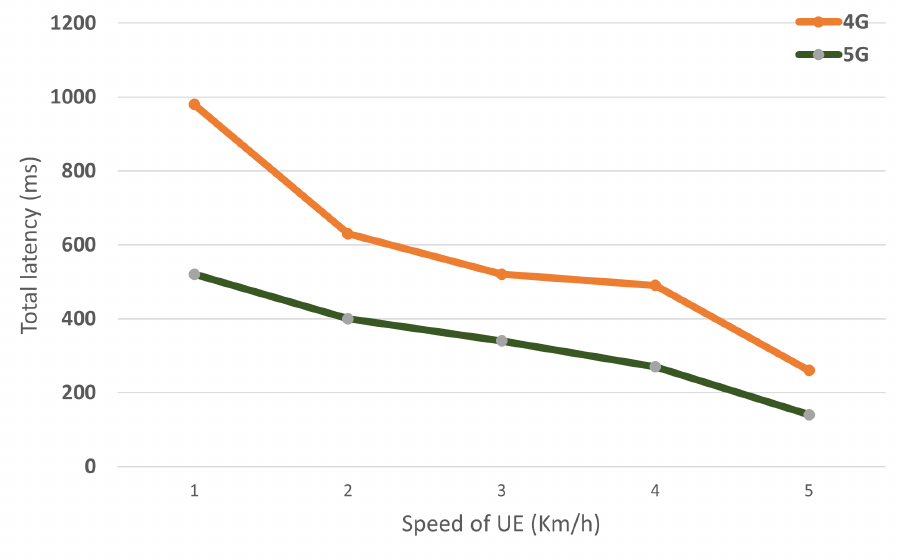
Figure 15. Comparison of 4G and proposed 5G in terms of latency of Intra-Handover with varied UE